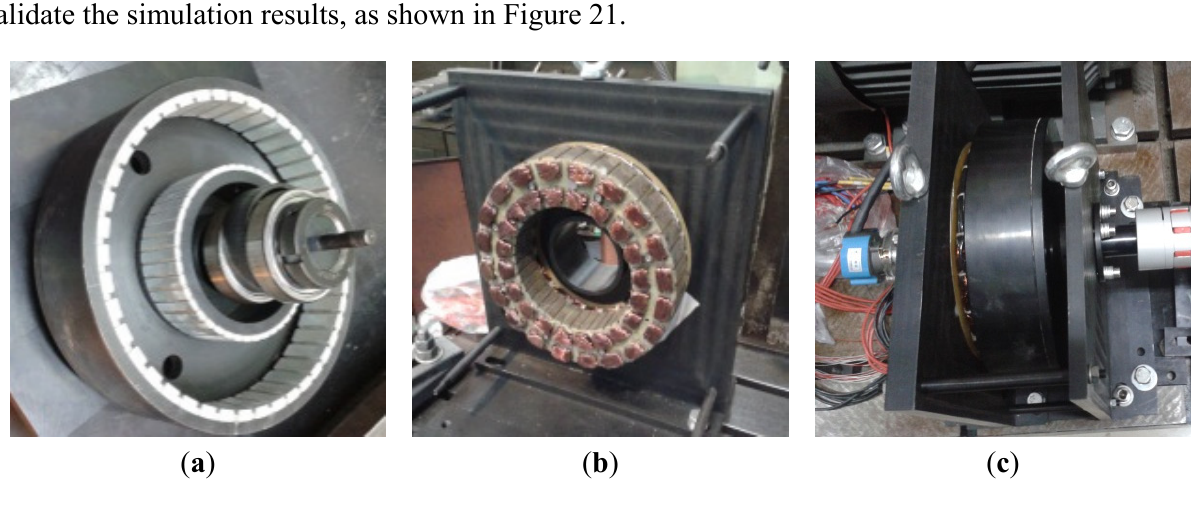
Figure 21. Main components of DRPMSM prototype: ( a ) rotor; ( b ) stator; and ( c )